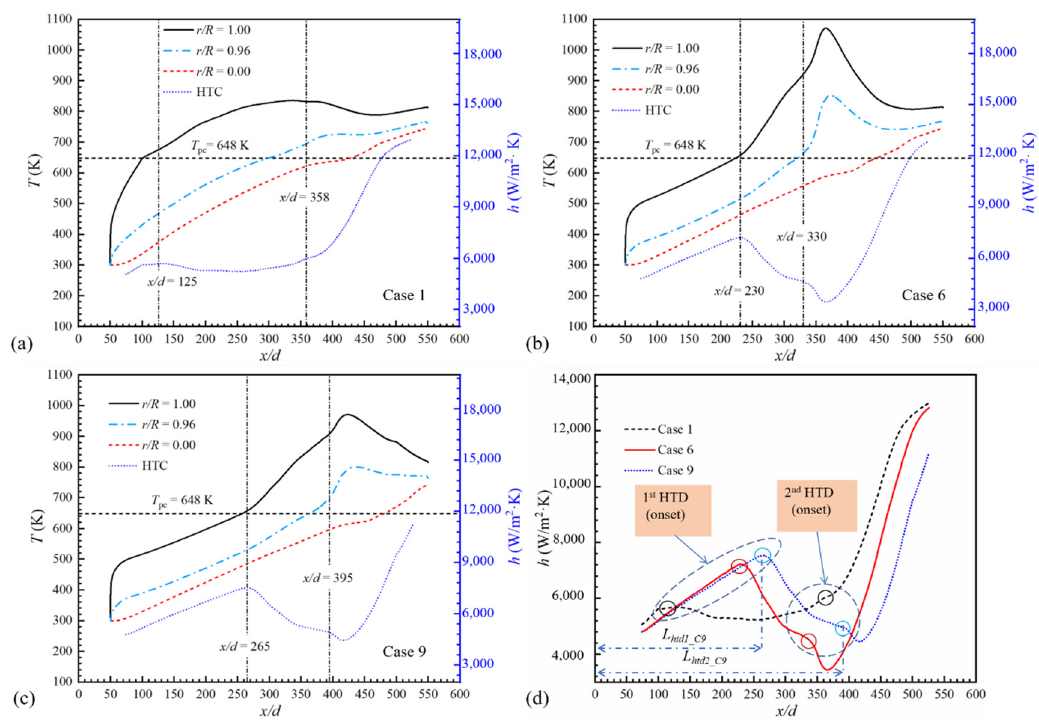
Figure 15. Variations in HTC and temperatures along the flow direction in different cases: ( a ) Case 1; ( b ) Case 6; ( c ) Case 9; ( d ) comparison of HTC in three cases.